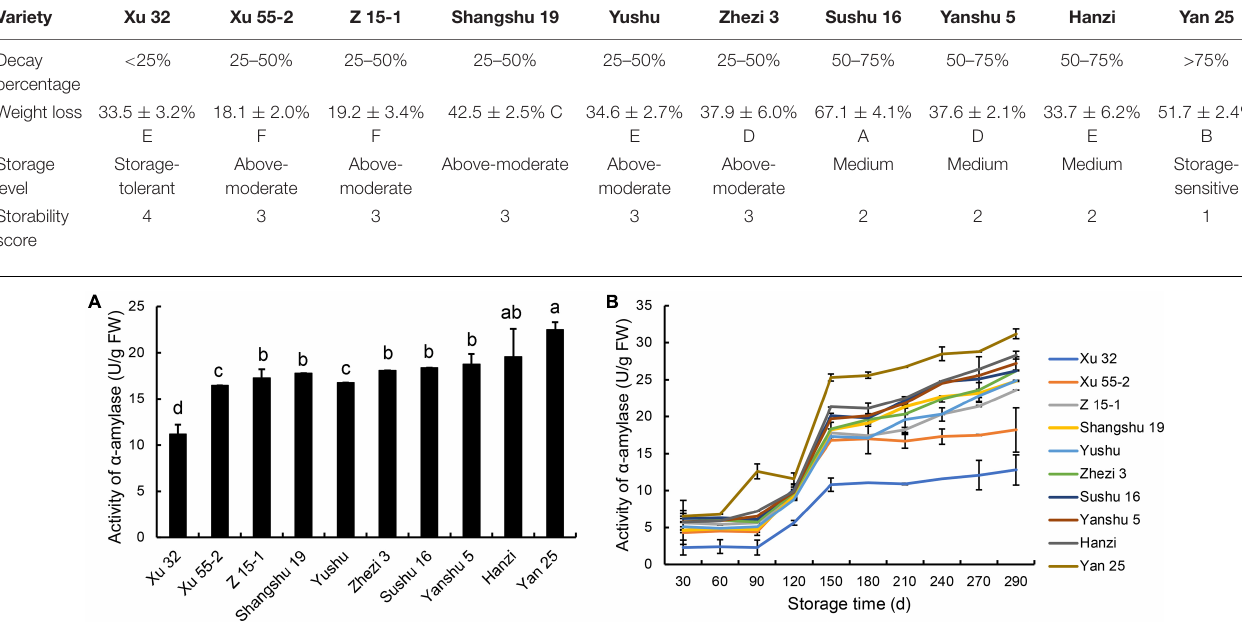
Frontiers in Plant Science |